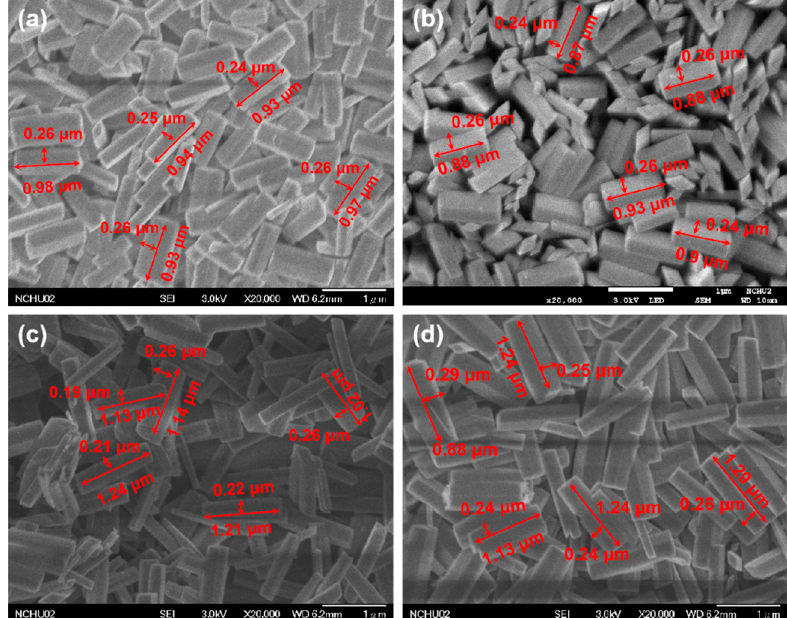
Figure 5. FE-SEM Ga 2 O 3 obtained after annealing GaOOH at 500 °C: ( a ) 0.05 M; ( c ) 0.075 M; and 600 °C: ( b ) 0.05 M; ( d ) 0.075 M.